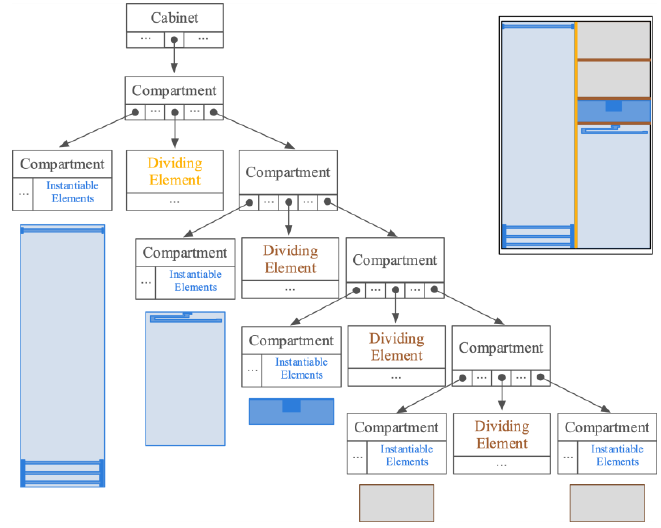
Figure 2. Diagram representing the Cabinet structure for a two-body